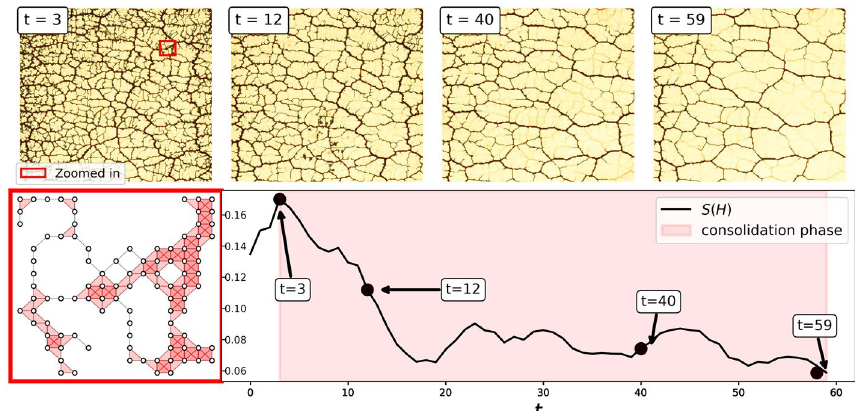
Fig. 7 P. polycephalum hypergraphs. On top: P. polycephalum images and hypernetworks extracted from them. Bottom left: a zoomed-in part of the hypergraph shown inside the red rectangle on top. Bottom right: covered area as a function of time. The red shade highlights a tentative consolidation phase towards optimality